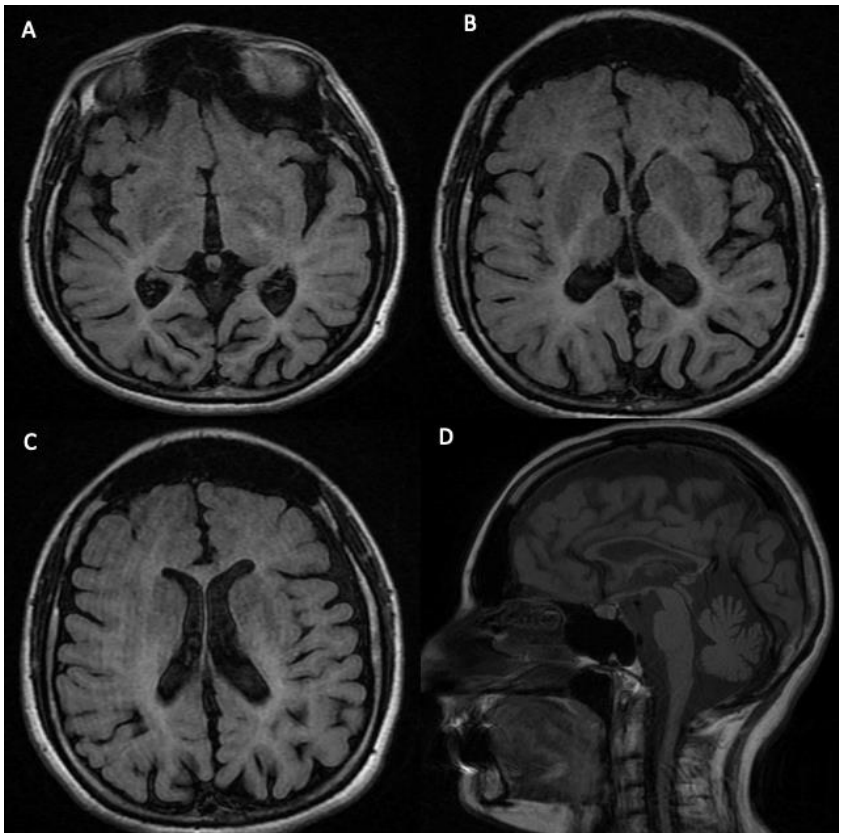
Figure 3. The brain MRI sequences show diffuse, bilateral, and relatively symmetrical cerebral white-matter hyperintensities, consistent with areas of hypomyelination, particularly evident in the subcortical and periventricular areas in T2-weighted and FLAIR images ( A – C ). In the same sequences, the extra-axial cerebrospinal fluid (CSF) spaces (including sulci, fissures, and ventricles), especially along the high-convexity area, are dilated. Sagittal T1-weighted image ( D ) shows a marked thinning of the corpus callosum, a verticalization of the tentorium, and olives and pontocerebellar hypoplasia. No signal/morphology alterations are evident in the cervical medulla.